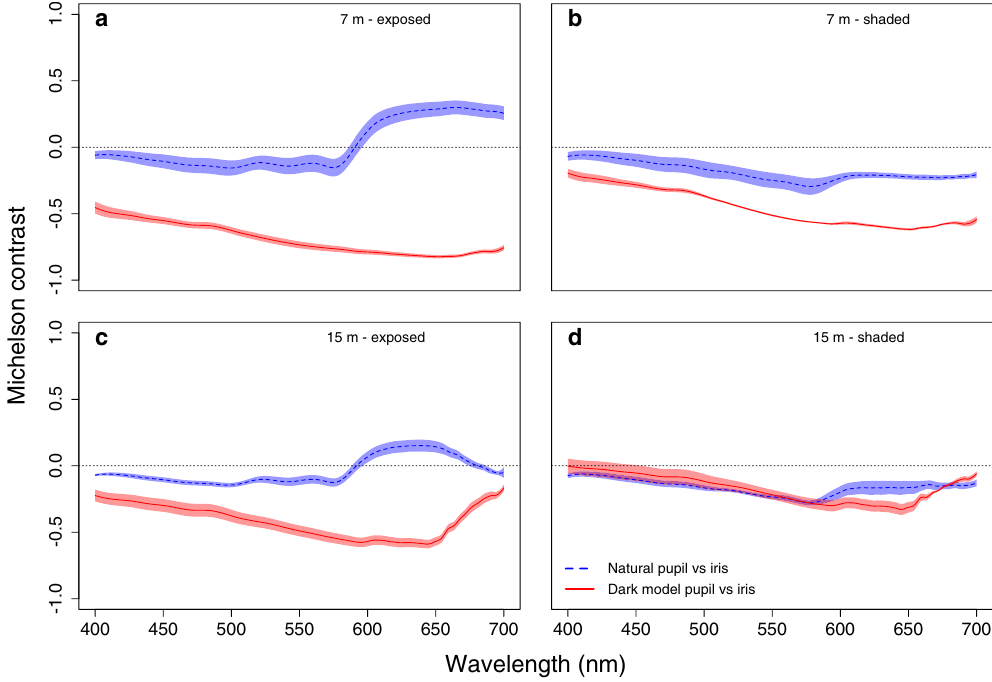
Figure 3. Michelson contrast at each wavelength between natural pupil or dark model pupil against the iris in the field. Measurements are from exposed and shaded Scorpaena porcus (n = 3 ind.) at 7 and 15 m depth. Positive values indicate that pupils are brighter than the irides. Shaded areas represent the standard error of the mean. (a) Exposed and (b) shaded fish at 7 m. (c) Exposed and (d) shaded fish at 15